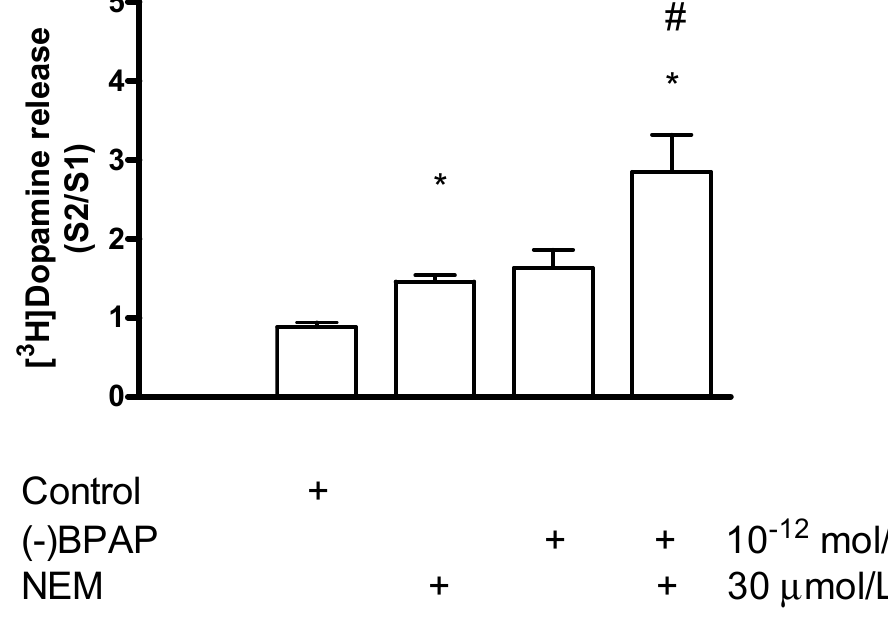
Figure 19. N-Ethylmaleimide (NEM) NEM potentiated the ( − )BPAP-stimulated [ 3 H]dopamine release in rat striatum. For the experimental procedure, see Figure 2A. ( − )BPAP was added to the slices from fraction 8 in a concentration of 10 − 12 mol/L. NEM was added to the slices from fraction 12 in a concentration of 30 µ mol/L and drugs were maintained throughout the experiment. One-way ANOVA followed by the Dunnett’s test, F(3,26) = 8.740, p = 0.048, control vs. NEM and ( − )BPAP effect # p < 0.05. Student t -statistics for two-means, control vs. NEM effect * p < 0.01, NEM vs. NEM and ( − )BPAP effect * p < 0.05, ( − )BPAP vs. ( − )BPAP/NEM effect * p < 0.05, mean ± S.E.M., n =